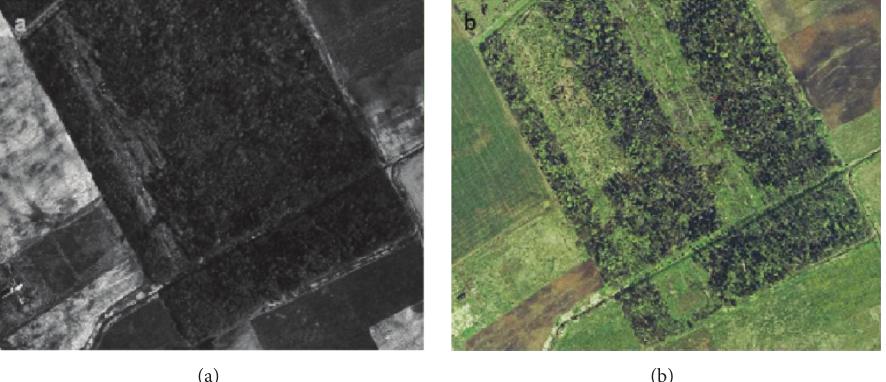
Figure 10: (a) Mature forest in 1995 on the orthophoto image, (b) the orthophoto image in 2012: one part is deforested and the young stands are